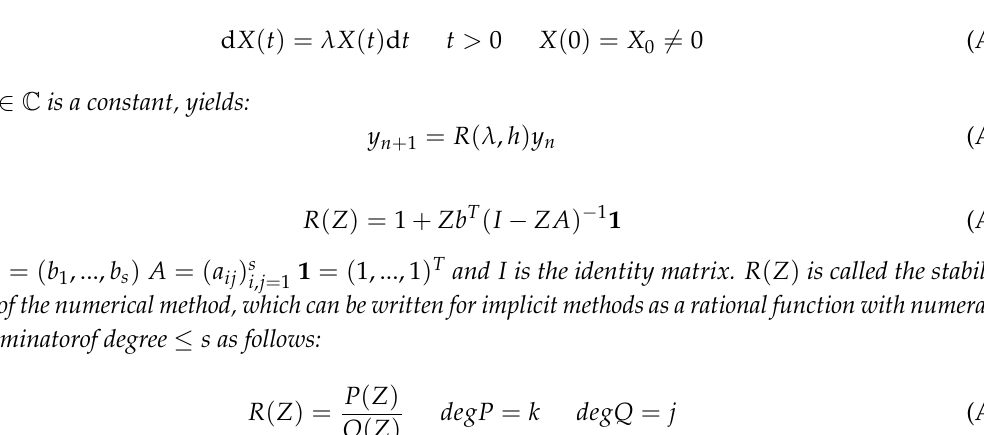
Figure A1. The Lobatto3C methods of order two ( left ) and order four ( right